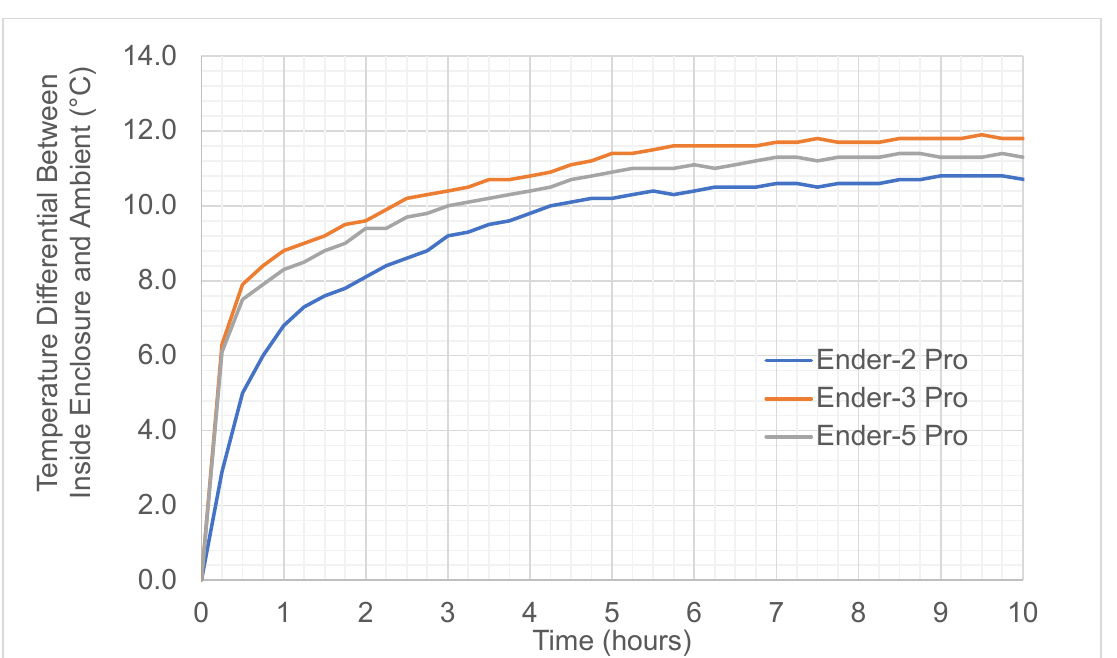
Figure 6. Temperature differential inside and outside the printer enclosure.